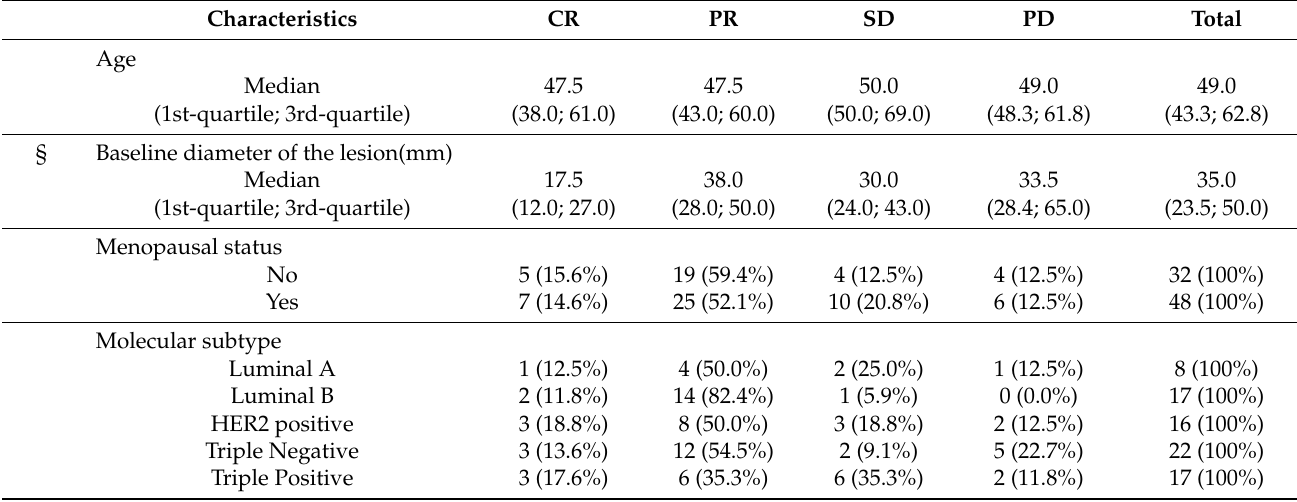
Table 7. Response distribution to NAC with respect to patients’ characteristics and molecular subtype. Characteristics